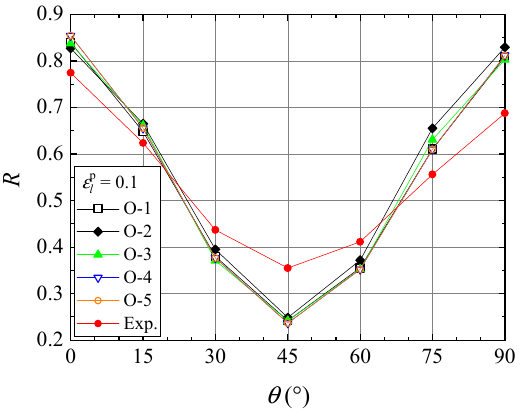
Figure 7. R values predicted with model O-1, O-2, O-3, O-4, and O-5 are compared with the experimental results of the O temper sheet. R value is evaluated at ε p